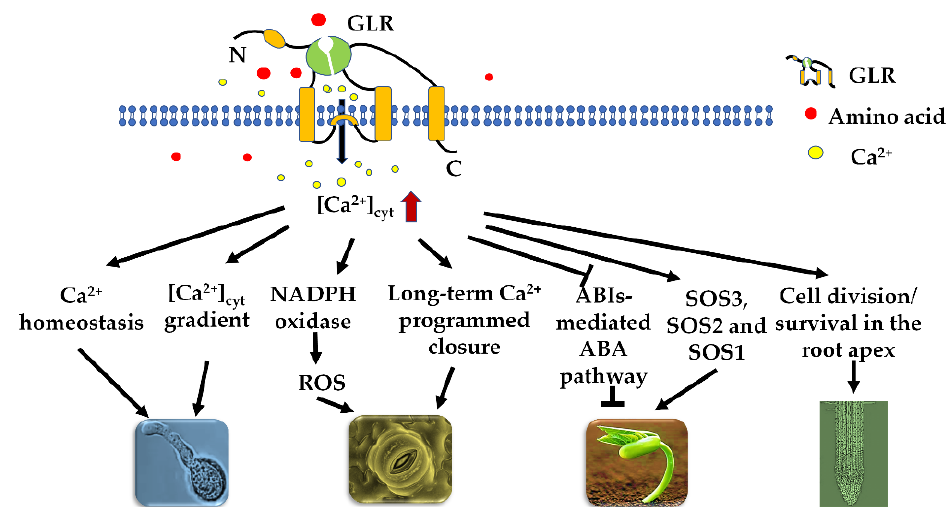
Figure 1. Summary of the main roles played by glutamate receptor-like channels (GLRs) in various physiological processes in plants. ABI, ABSCISIC ACID INSENSITIVE.